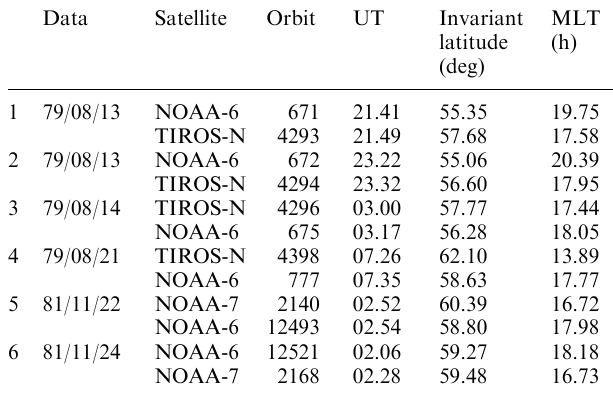
Table 1. Summary of data on spatial locations of the